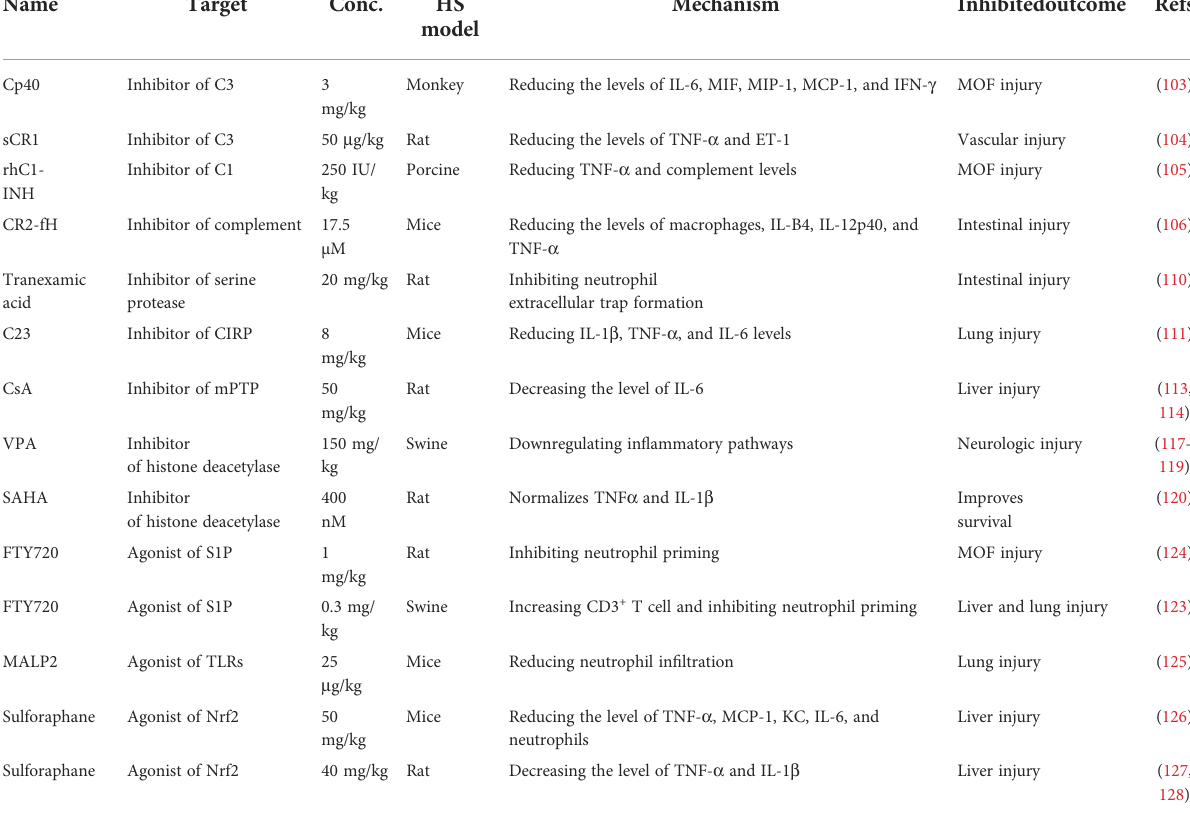
TABLE 3 Summary of the applications of small molecule inhibitor or agonist therapy in a hemorrhagic shock model.